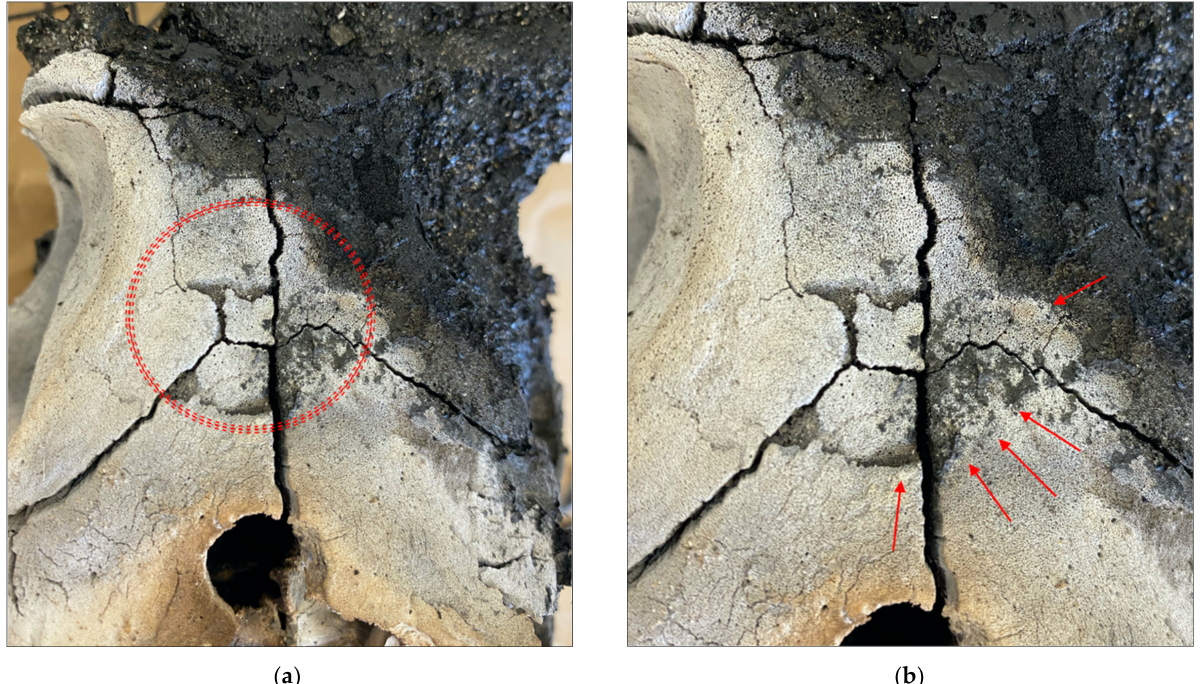
Figure 9. Hammer sample ( a ) region of impact exhibiting retained plastic deformation; ( b ) closer image of